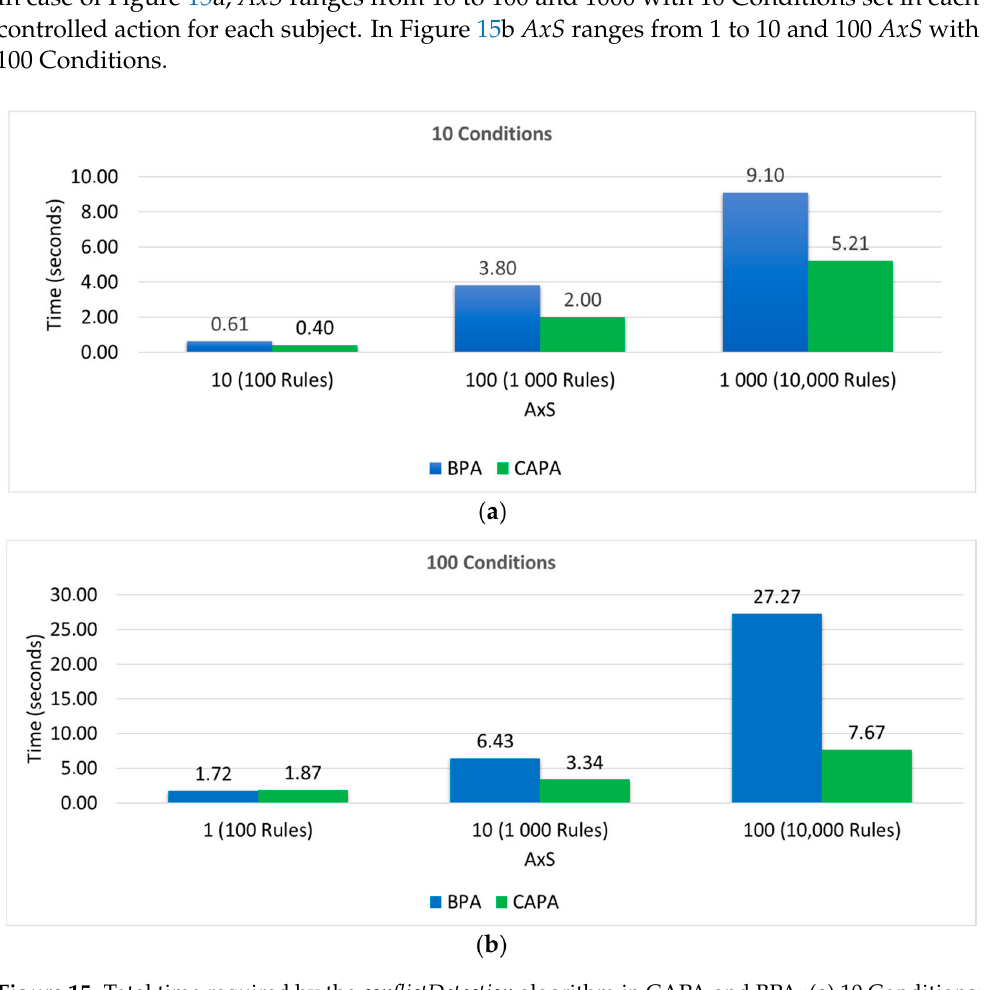
Figure 15. Total time required by the conflictDetection algorithm in CAPA and BPA: ( a ) 10 Conditions; ( b ) 100